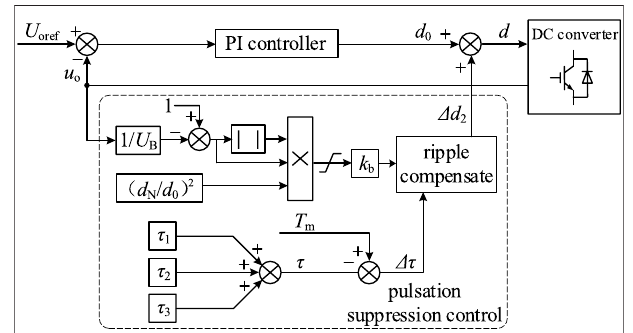
Figure 7 is a control block diagram of the proposed strategy.